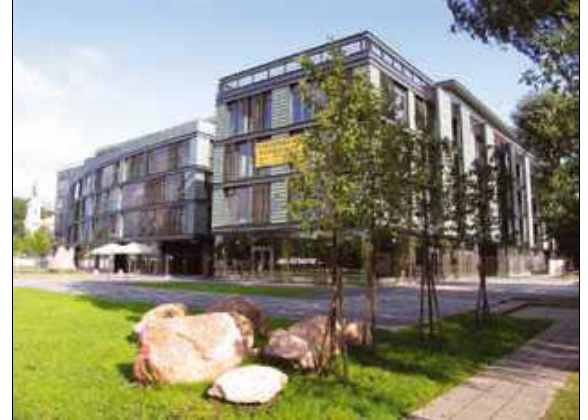
Fig. 15. “Mindau­gas apartments“. block of flats with offices in Olimpiečiai st. a­rch. k. Pempė, r­. kirdu­lis, L. Jančytė